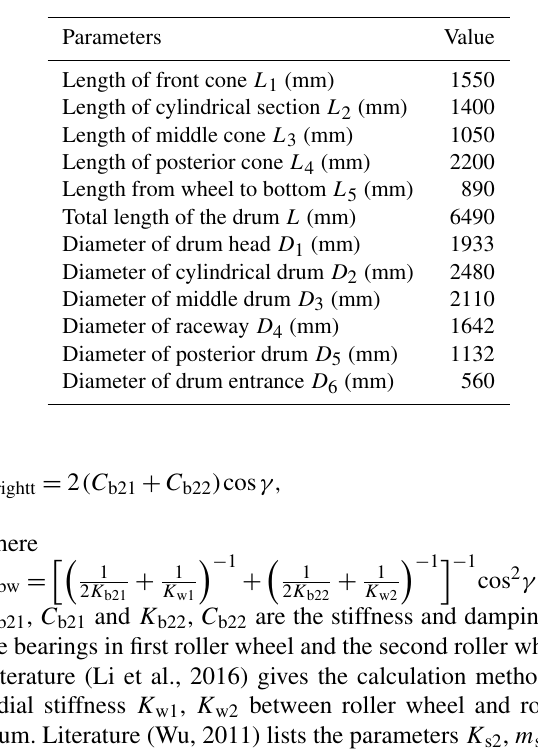
Figure 13. Stiffness and damping model of a single rolling wheel. Table 1. Structural parameters of concrete mixer rotating